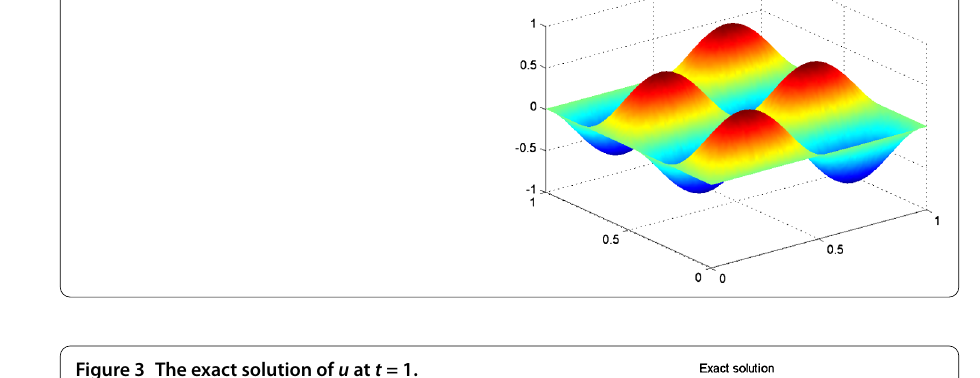
Figure 3 The exact solution of u at t =